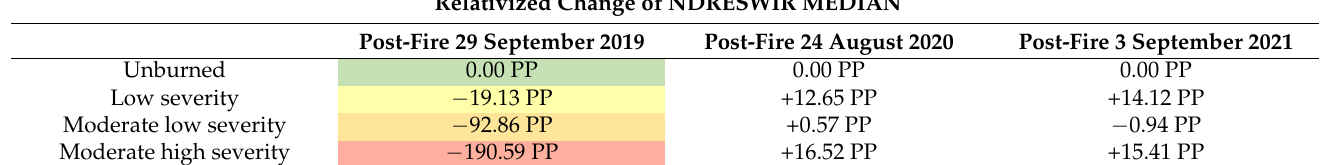
Table 10. NDRESWIR time series: relativizing the phenological difference of the selected vegetation index dates at the El Saco